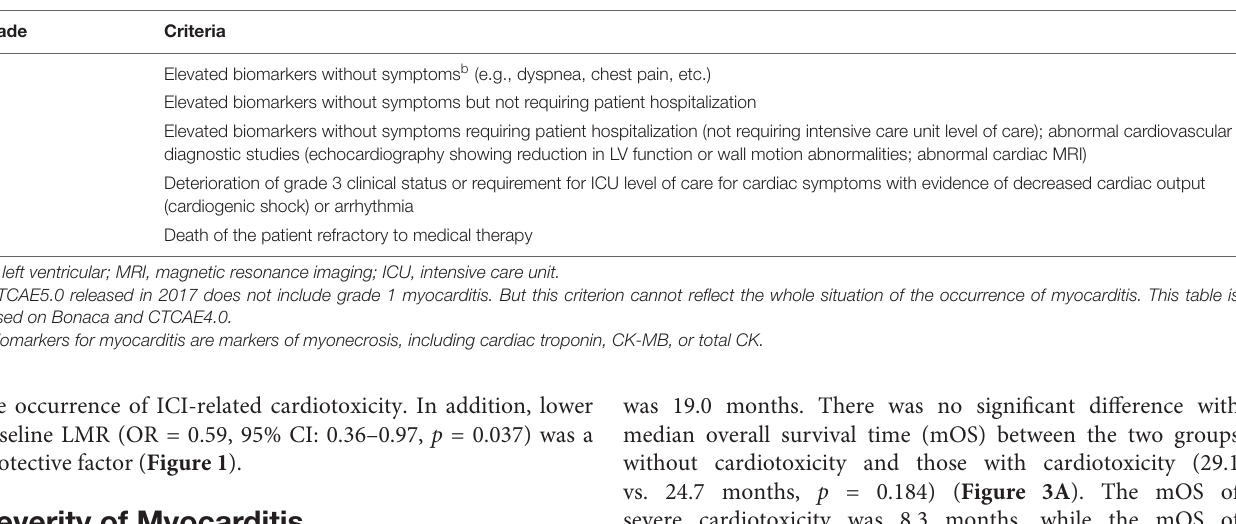
TABLE 1 | Criteria for myocarditis severity